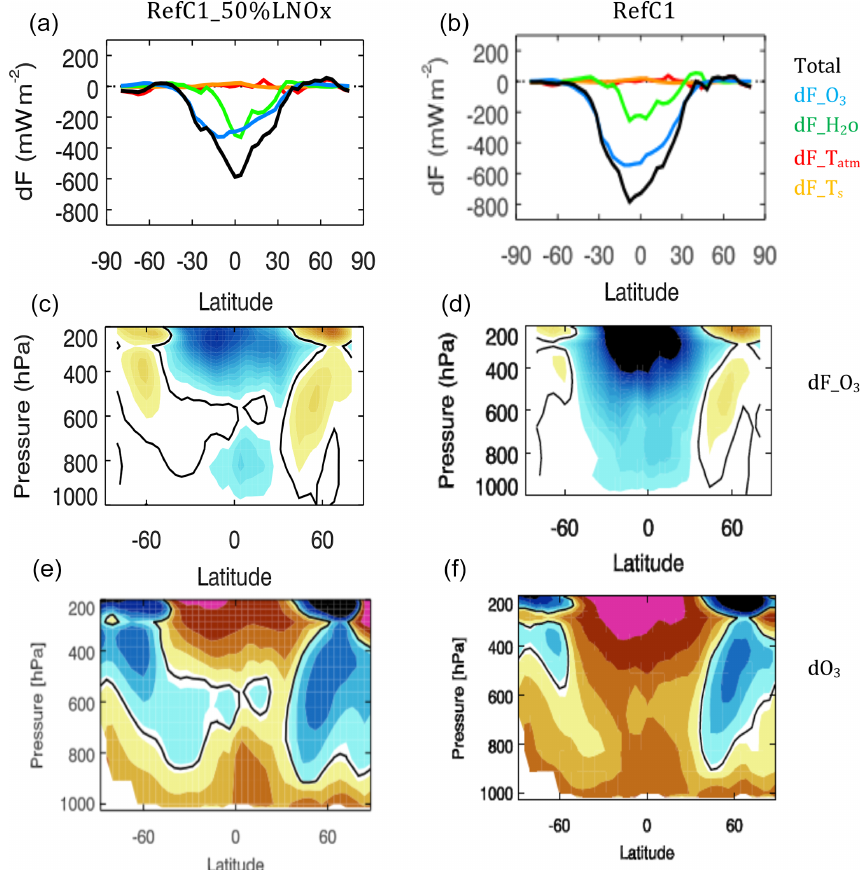
Figure A1. The comparison of the MRI-ESM1r1 experiment of half LNO x in total flux bias (a, b) , O 3 radiative bias (c, d) , and O 3 bias (e, f) . (a, c, e) New run with half LNO x . (b, d, f) RefC1